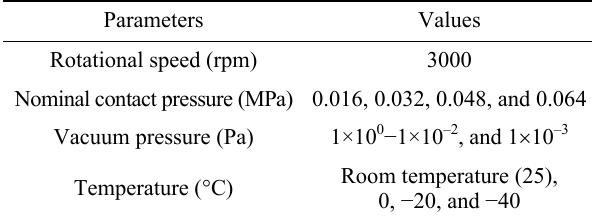
Fig. 1 A schematic diagram of the ring-on-ring braking test system: 1-flywheel, 2-bearing, 3-clutch, 4-rotation shaft, 5-air cylinder, 6-concrete base, 7-feed belt, 8-motor, 9-counterpart ring, 10-friction ring. T able 1 Test parameters employed in wear